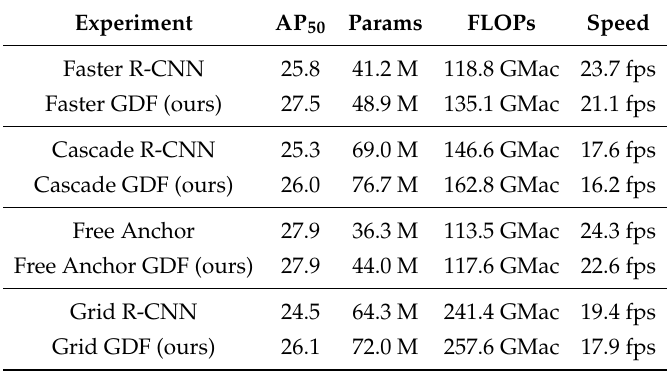
Table 3. Accuracy, complexity and speed comparison on the UAVDT